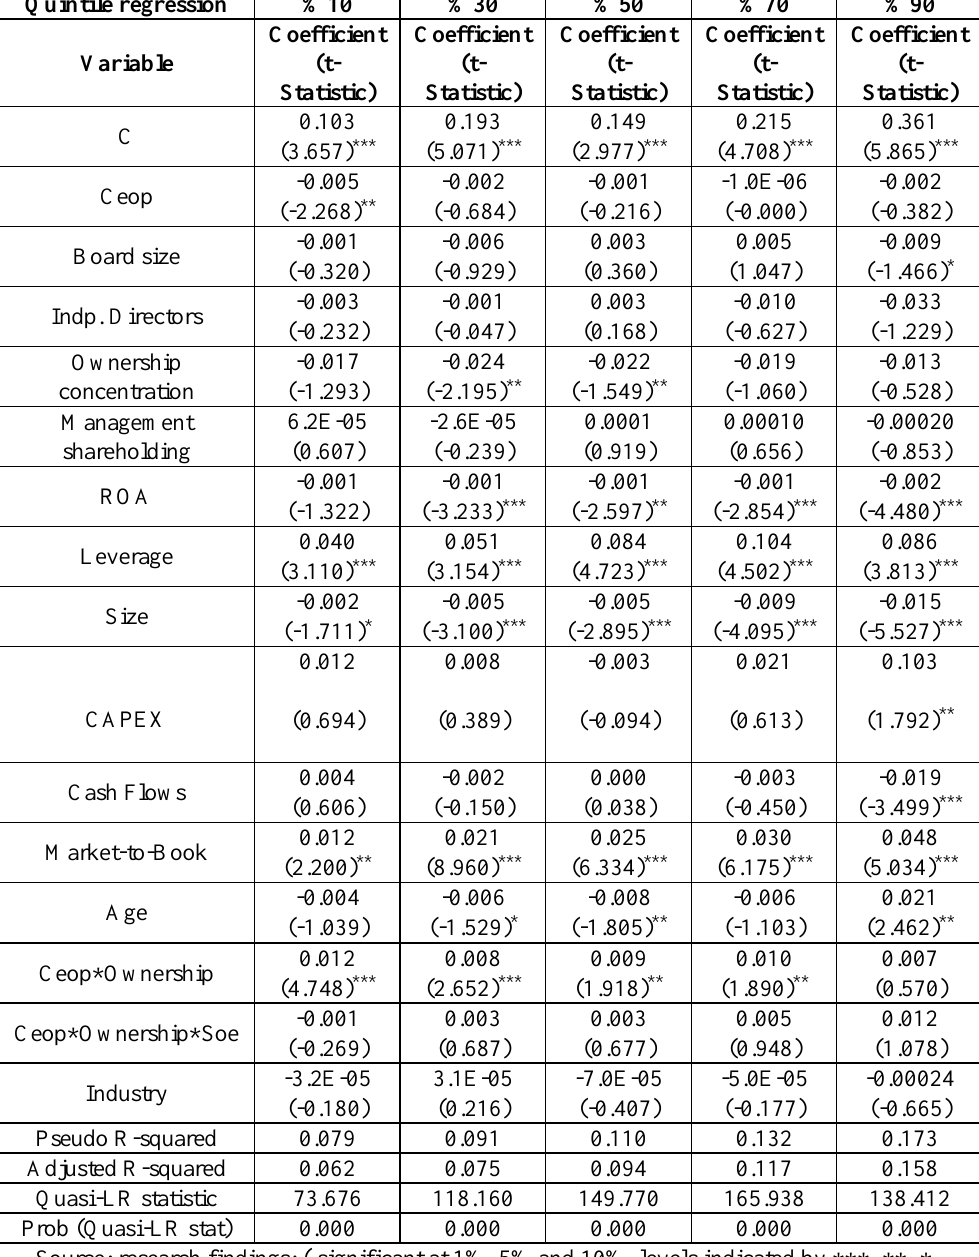
Table 7. fitness results of model2 (dependent variable: specific